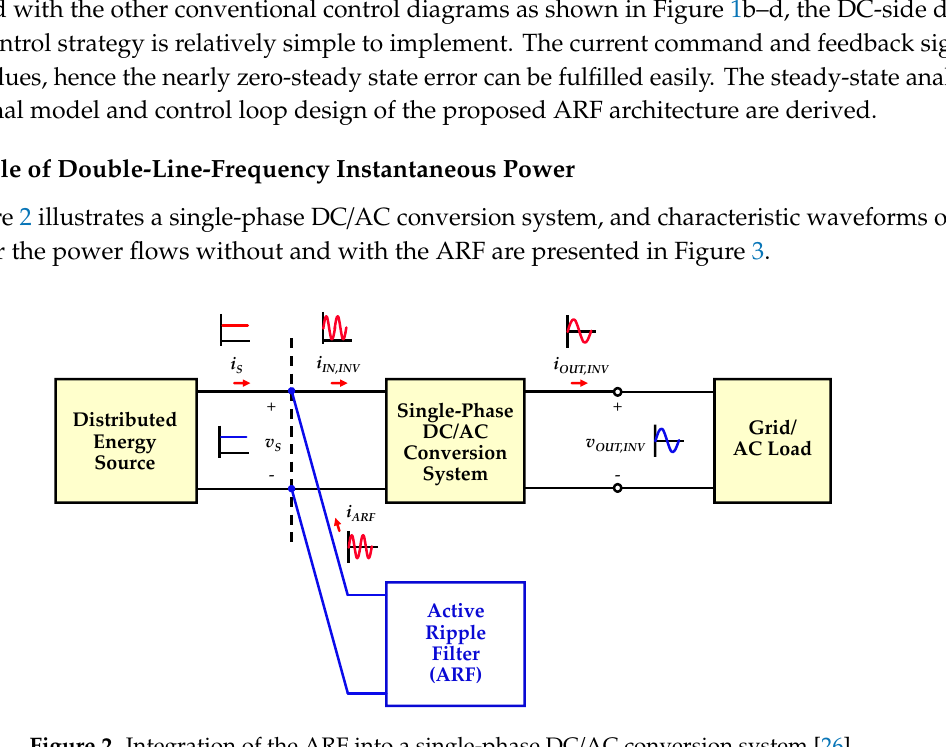
Figure 3. Key waveforms to illustrate the operating principles for double-line-frequency components of a single-phase DC/AC conversion system [26]: ( a ) without the ARF and ( b ) with the ARF.